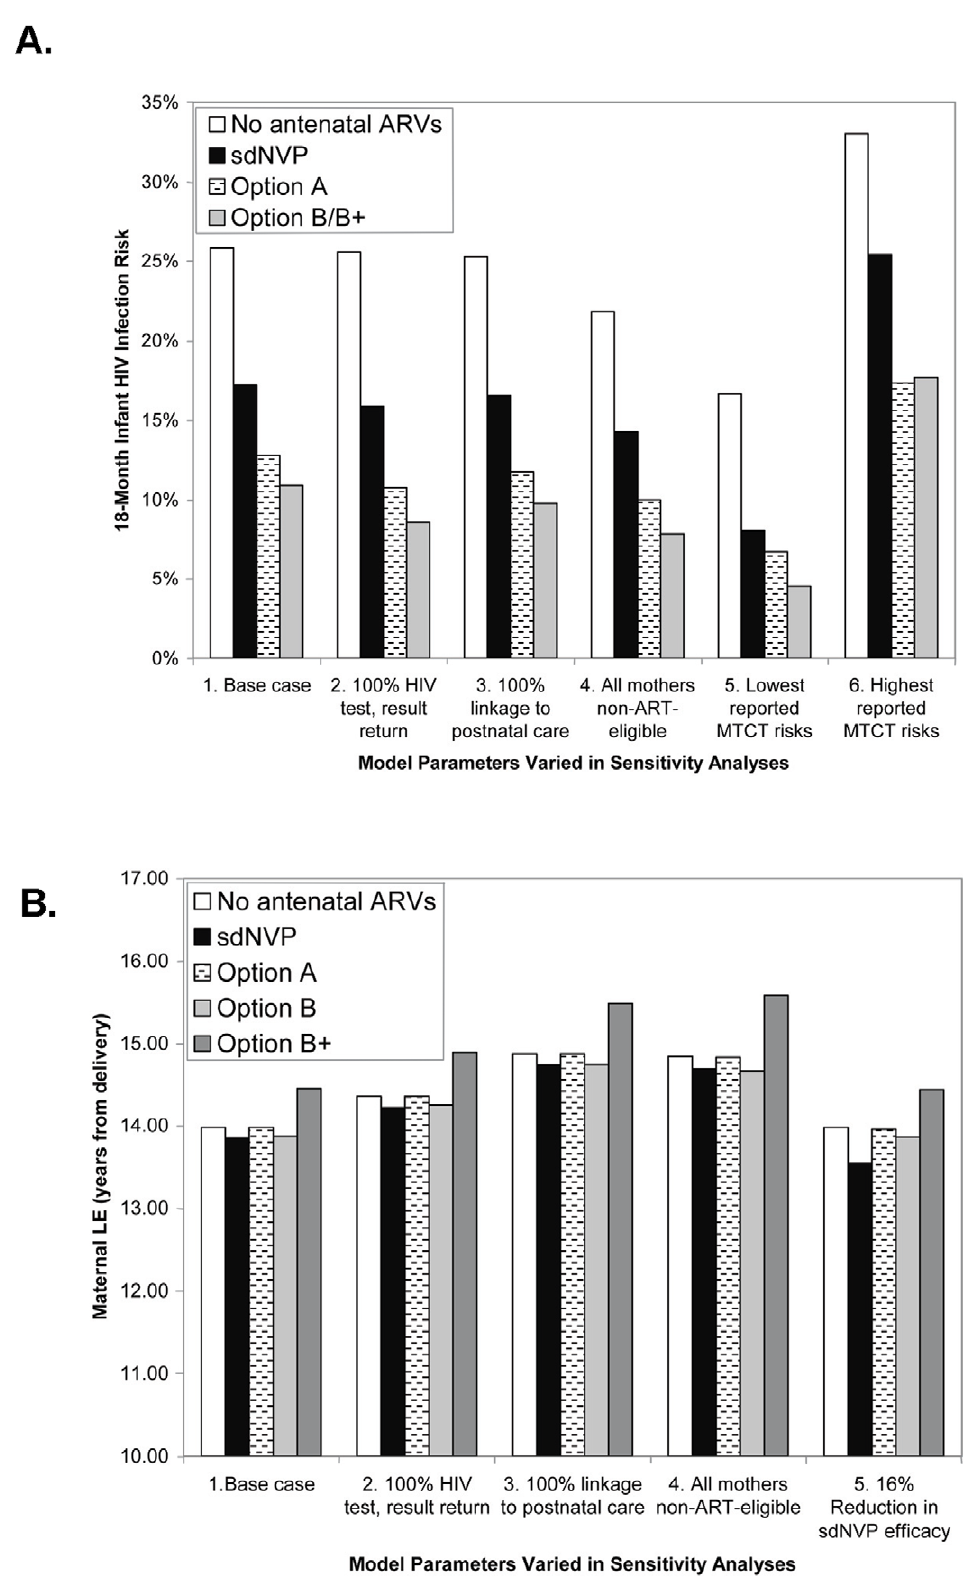
Figure 2. Key sensitivity analyses, identifying selected parameters producing substantial changes in model results. As detailed in the Methods section and Appendix (Text S1), a substantial change in results was defined as: 1) a change in the relative order of the outcomes of the PMTCT regimens, or 2) a . 10% relative change in the difference between projected outcomes for each regimen. Panel 2a depicts parameters influencing 18-month mother-to-child HIV transmission risk, and Panel 2b depicts parameters influencing maternal life expectancy from delivery;